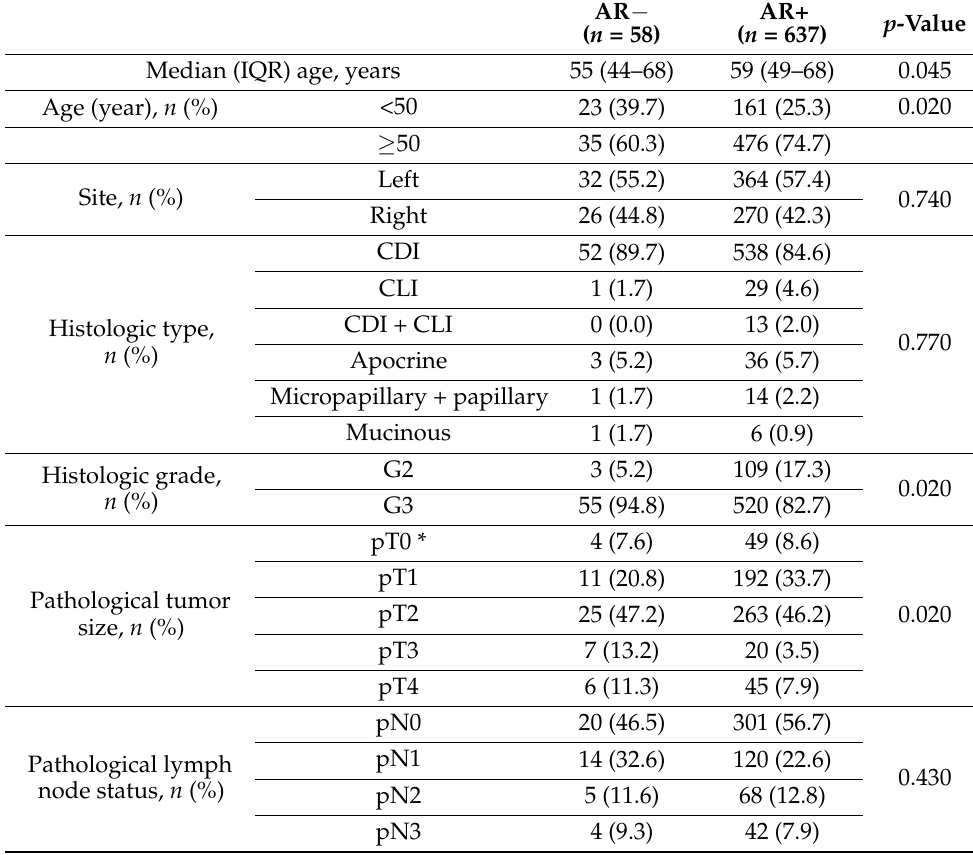
Table 3. Clinico-pathological data of 695 patients with HER2-positive breast cancer based on AR